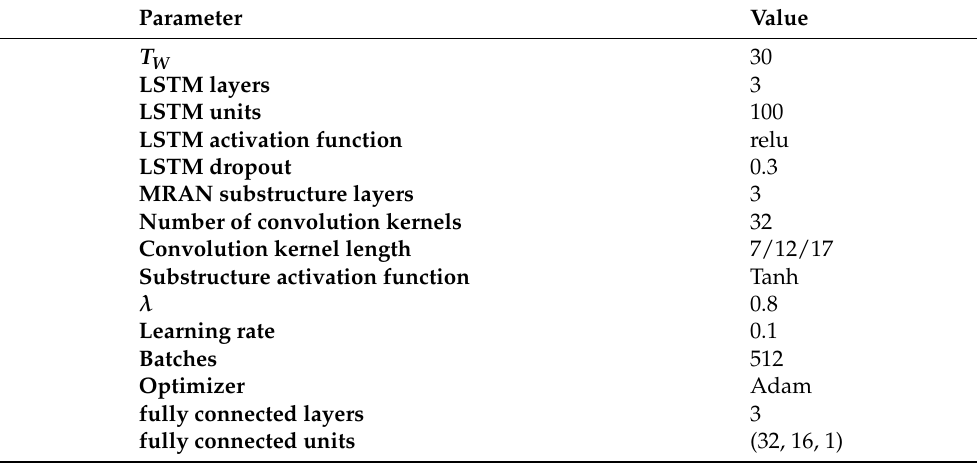
Table 3. LSTM-MRAN network